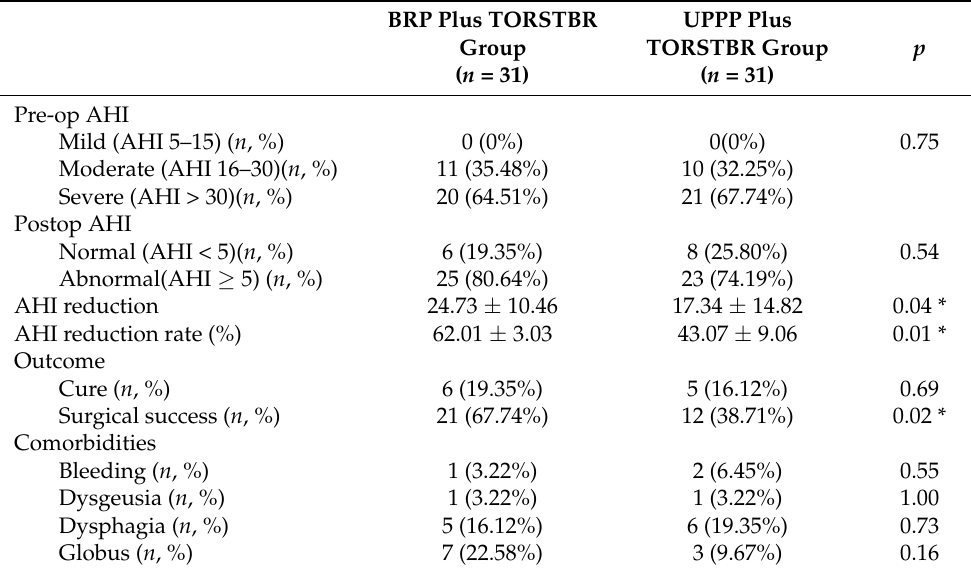
Table 3. Between-group comparison of the treatment